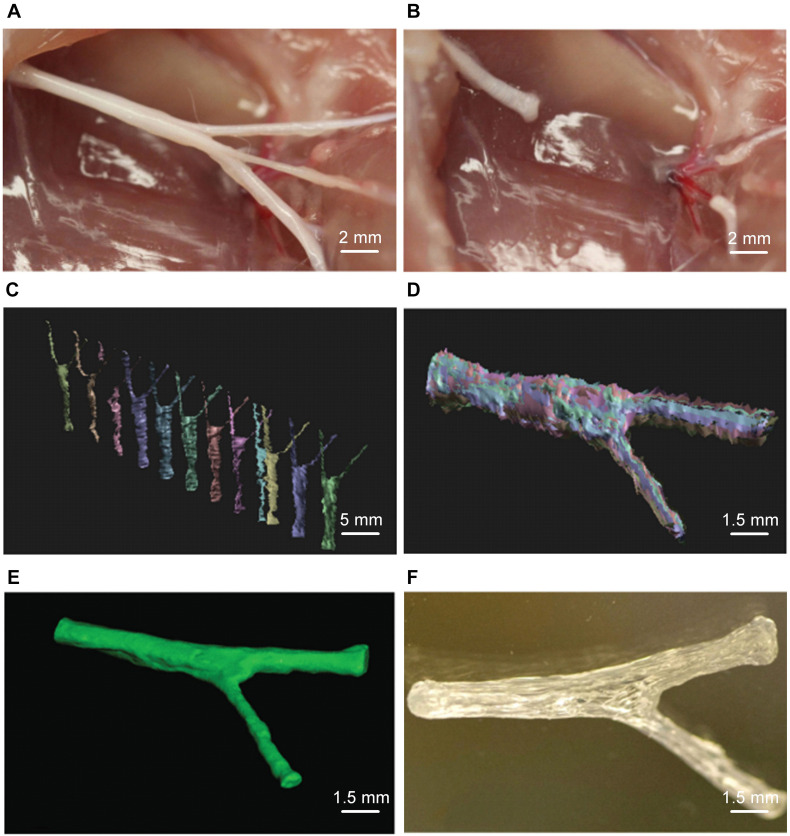
Microextrusion printing rat complex structure sciatic nerve conduit. (A) Photographs of sciatic nerve including both of sensory and motor nerve branches and (B) corresponding sciatic nerve defect. (C) Scans for 3D reconstruction from various perspectives by structured light scanning system. (D) The process of three-dimensional reconstruction of data. (E) Image after 3D reconstruction of the scan data of the sciatic nerve. (F) Image of the microextrusion printed sciatic nerve conduit. Reproduced with permission from Johnson et al. (2015).